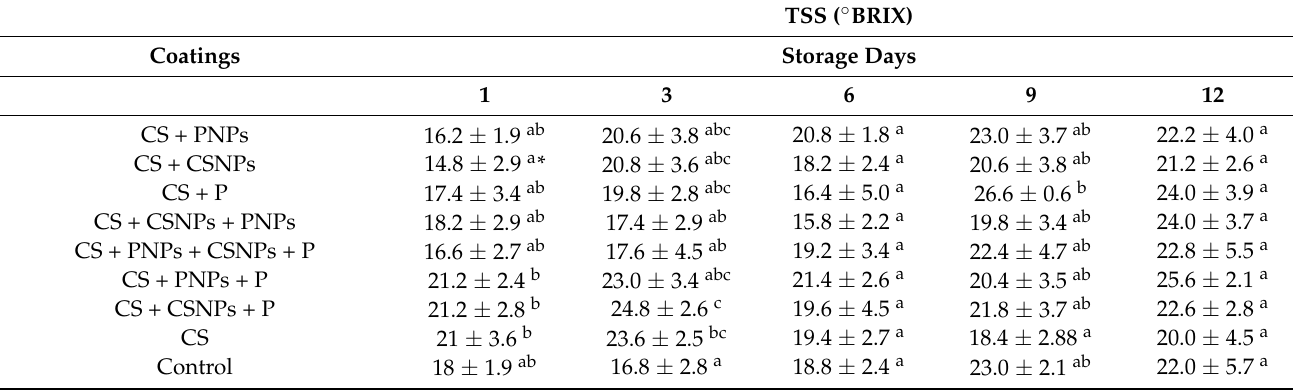
Table 2. Effect of edible chitosan/propolis coatings on total soluble solids (TSS) concentration of fig fruit stored for 12 days at 4 ◦